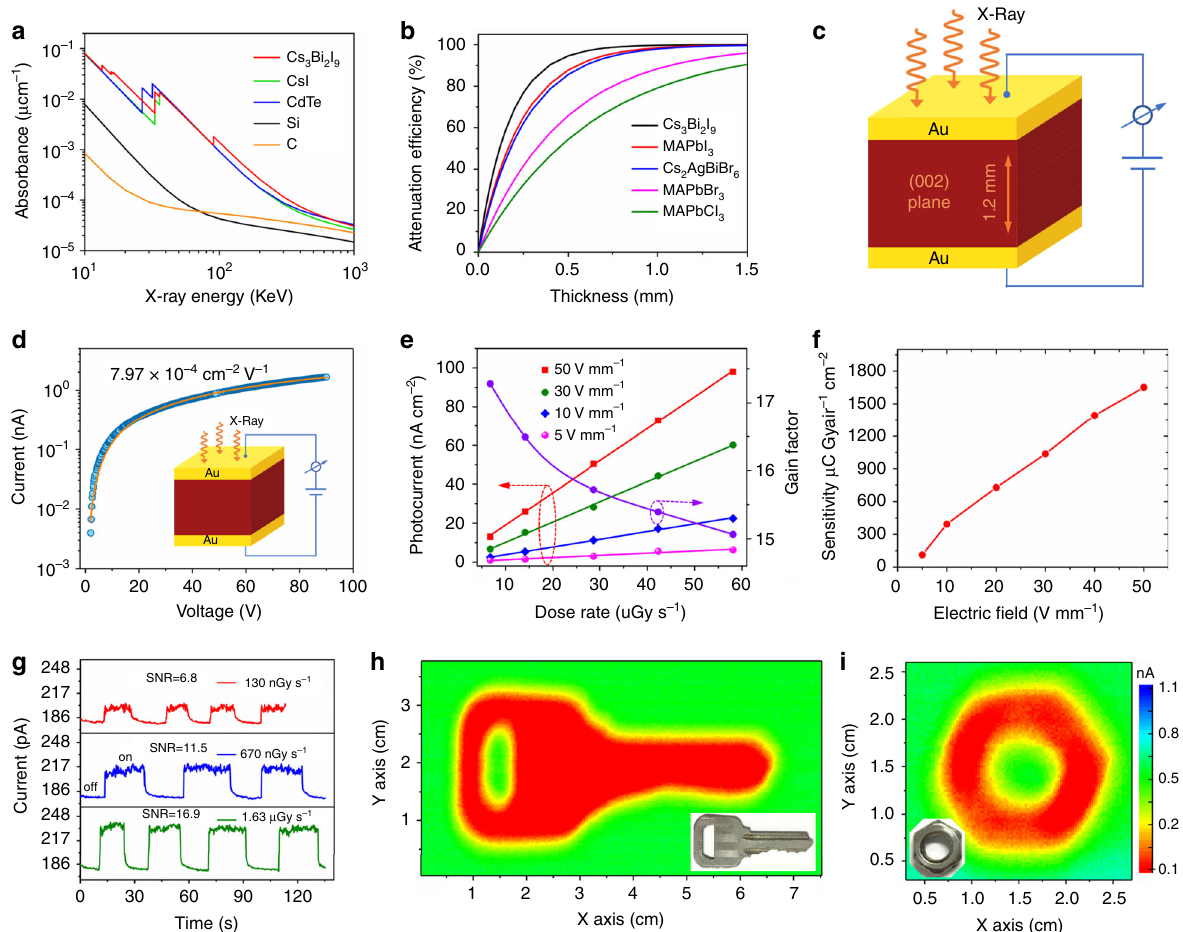
Fig. 5 Performance of Cs 3 Bi 2 I 9 PSC X-ray detector and imaging. a Absorption coef fi cients of Cs 3 Bi 2 I 9 , CsI, CdTe, silicon, and carbon as a function of photon energy. b Attenuation ef fi ciency of Cs 3 Bi 2 I 9 , MAPbI 3 , Cs 2 AgBiBr 6 , MAPbBr 3 , MAPbCl 3 , silicon, and carbon for 40 keV X-ray photons versus thickness. c Schematic of the Cs 3 Bi 2 I 9 PSC-based X-ray detector structure. d Photoconductivity measurement of the Cs 3 Bi 2 I 9 PSC device with the inset illustrating the device structure. e X-ray-generated photocurrent density and gain factor versus dose rate under different applied biases. f Sensitivity under different electric fi eld of the Cs 3 Bi 2 I 9 PSC X-ray detector. g X-ray photocurrent response of the Cs 3 Bi 2 I 9 PSC device under electric fi eld of 50 V mm − 1 when exposed to different X-ray dose rates. h , i Photos and corresponding X-ray images of a key and a nut obtained using the Cs 3 Bi 2 I 9 SC detector (1 × 1 mm 2 ), as measured under 50 V mm − 1 electric fi eld with dose rate of 36.2 µ Gy air s − 1